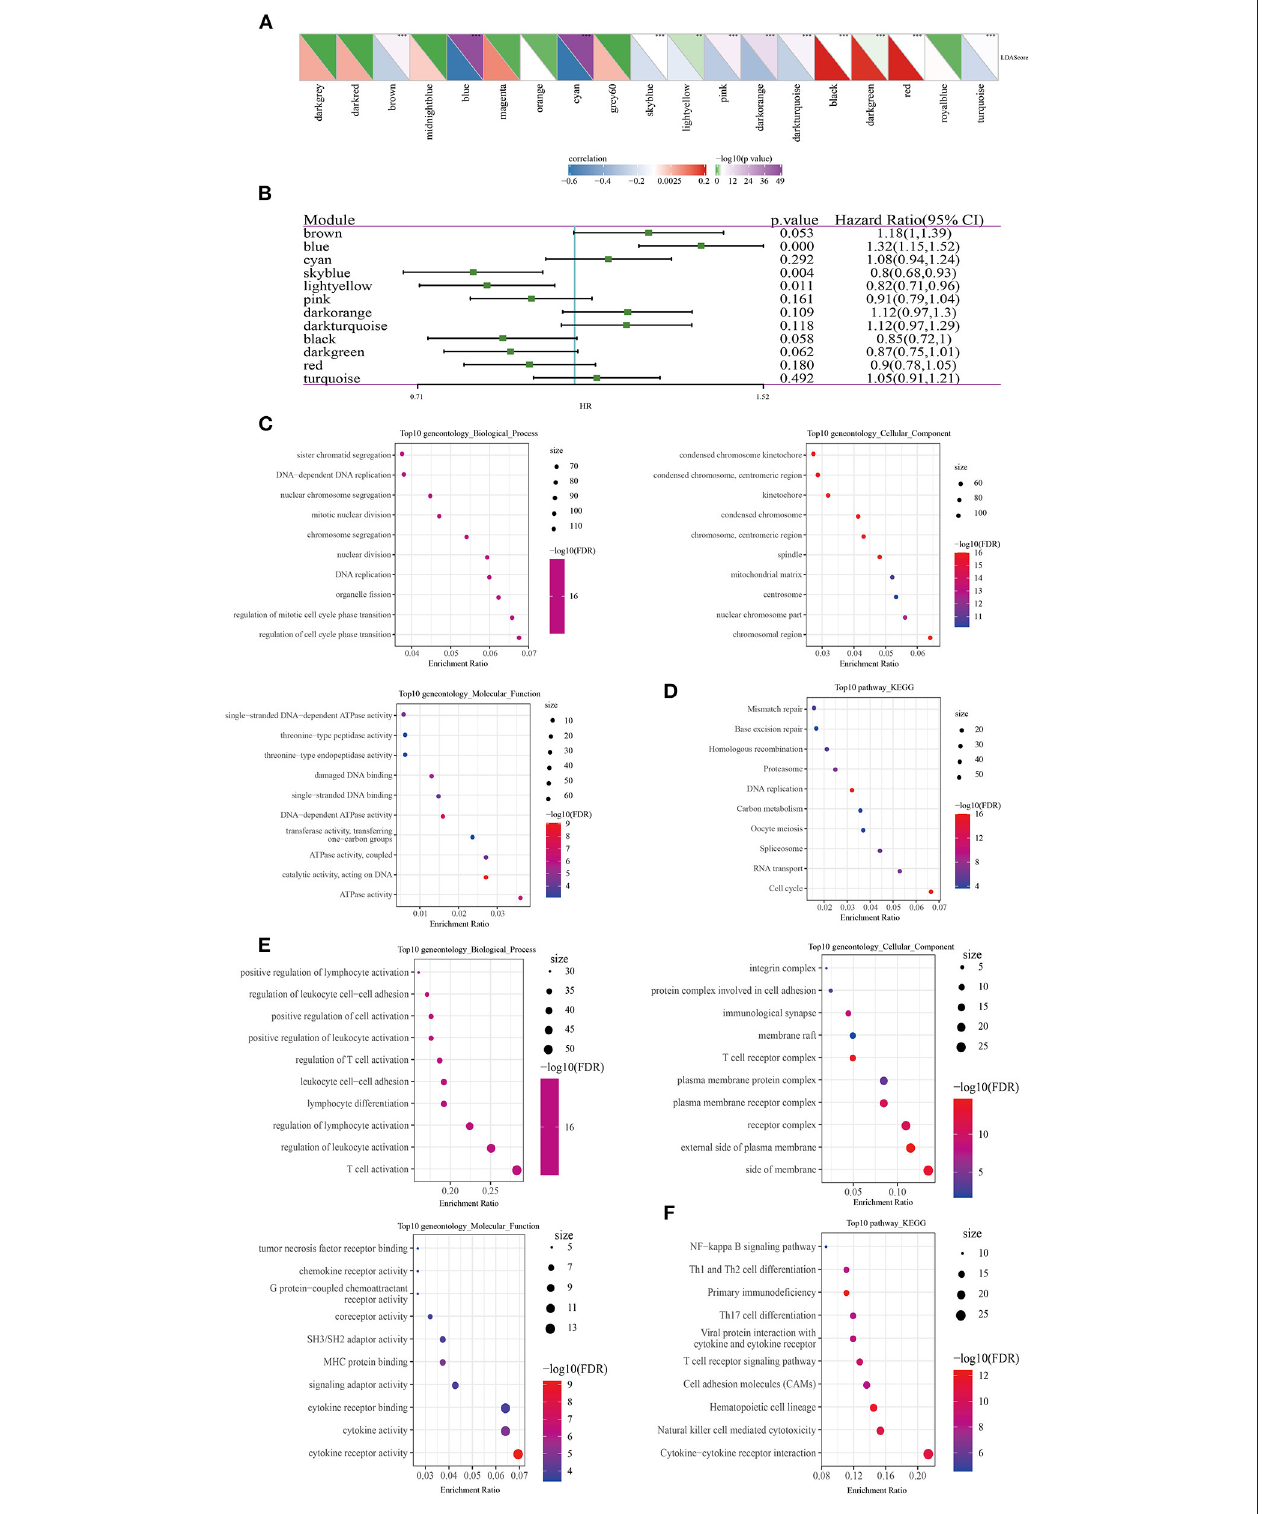
FIGURE 9 | Identification of LUAD prognostic-related modules and hub genes. (A) Correlation analysis between modules and LDA score. (B) Modules associated with LUAD prognosis were analyzed by univariate Cox screening. (C) The top 10 GO terms annotated by blue module annotations. (D) The top 10 KEGG pathways annotated by blue module annotations. (E) The top 10 GO terms enriched by the light yellow module. (F) The top 10 KEGG pathways enriched by the light yellow module.